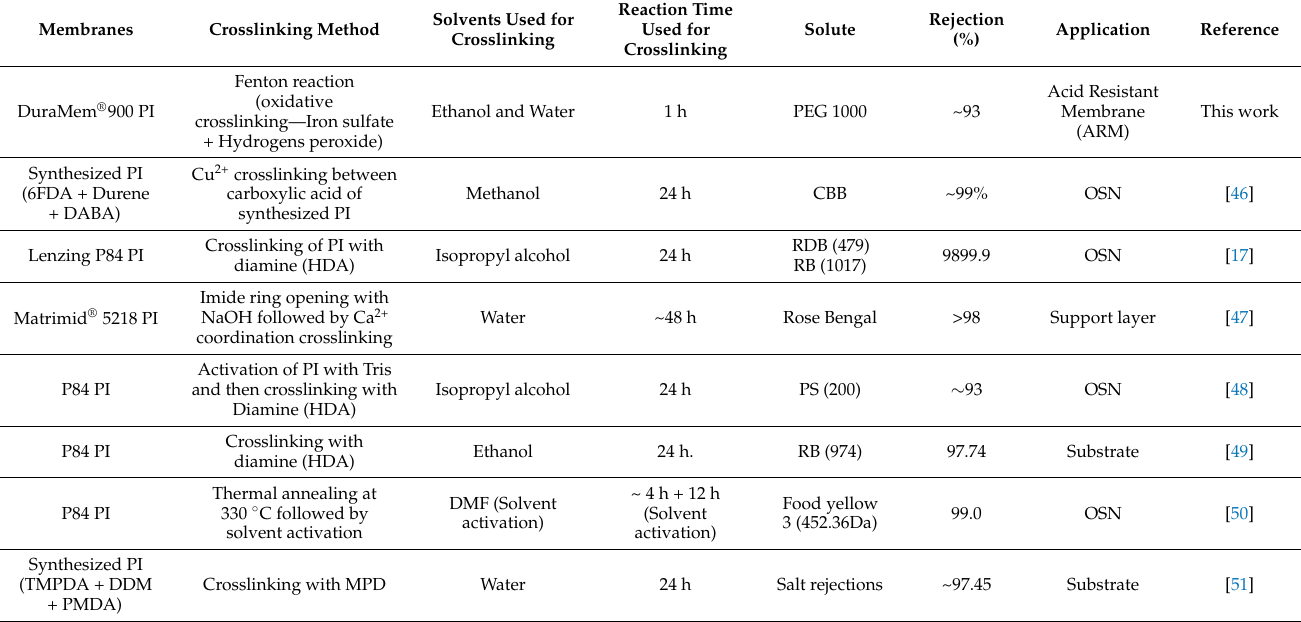
Table 2. Comparison of crosslinking methods of PI membranes.